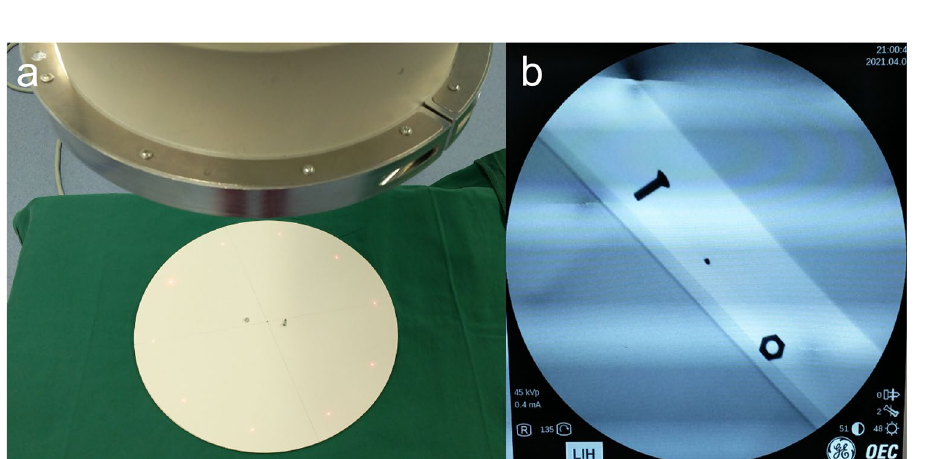
Figure 8. ( a ) C-arm camera with the locator was used to shoot the circular plate ( X = 30 cm, Y = 0°). ( b ) Center nail of the display circular plate overlapped the center point of the